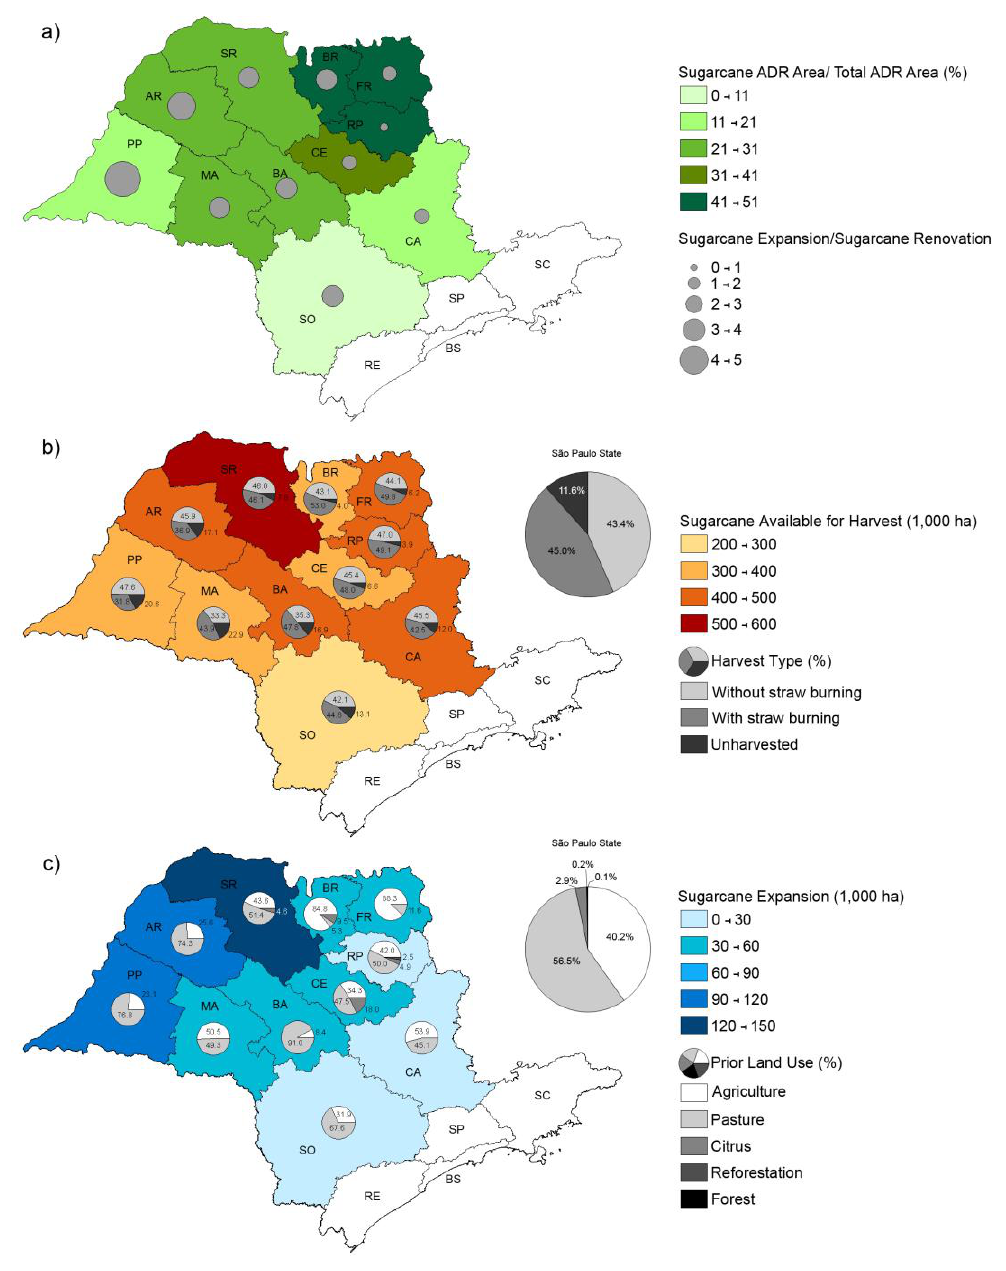
Figure 7. (a) Percentage classes of cultivated sugarcane area and ratio classes of expansion area to renovation area; ( b) Classes of available sugarcane area and proportions of: harvested with straw burning, harvested without straw burning and unharvested; ( c) Classes of sugarcane expansion area and proportions of land use change for: pasture, agriculture, citrus, forest (natural vegetation) and reforestation for the Administrative Regions (ADRs) of Araçatuba (AR), Baixada Santista (BS), Barretos (BR), Bauru (BA), Campinas (CA), Central (CE), Franca (FR), Marília (MA), Presidente Prudente (PP), Registro (RE), Ribeirão Preto (RP), São José do Rio Preto (SR), São José dos Campos (SC), São Paulo (SP) and Sorocaba